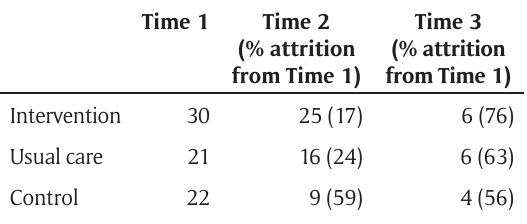
Table 1: Attrition rates over the three time